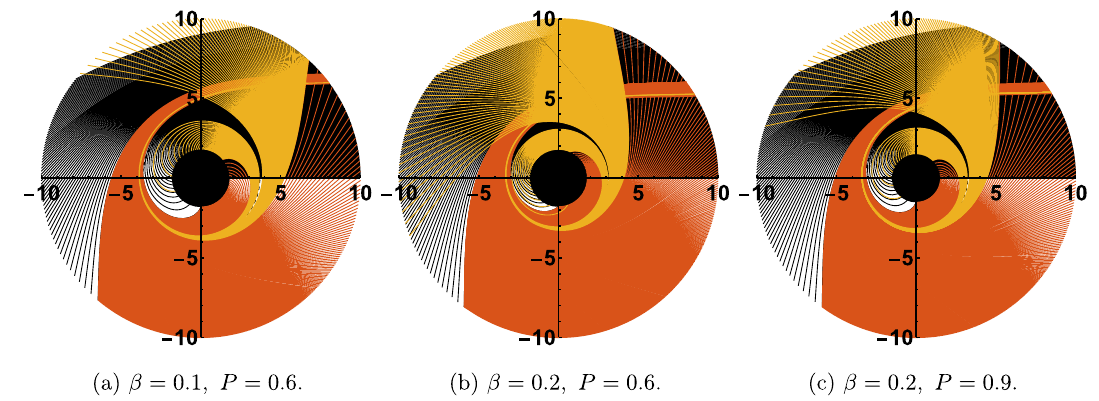
Fig. 12 Trajectories of photons. The black, red, and yellow curves represent the light rays corresponding to direct emission, lens ring, and photon ring, respectively. And the photon sphere is depicted here by